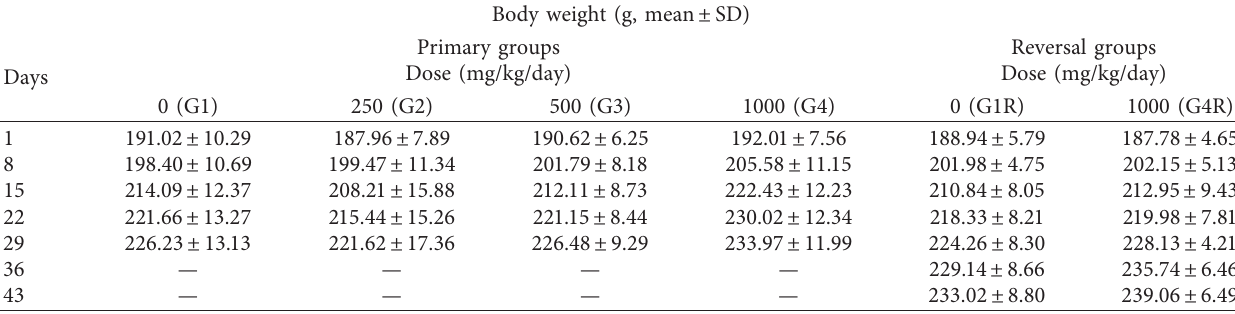
Table 4: Effect of oral administration of GMCT on body weight of female Wistar rats.